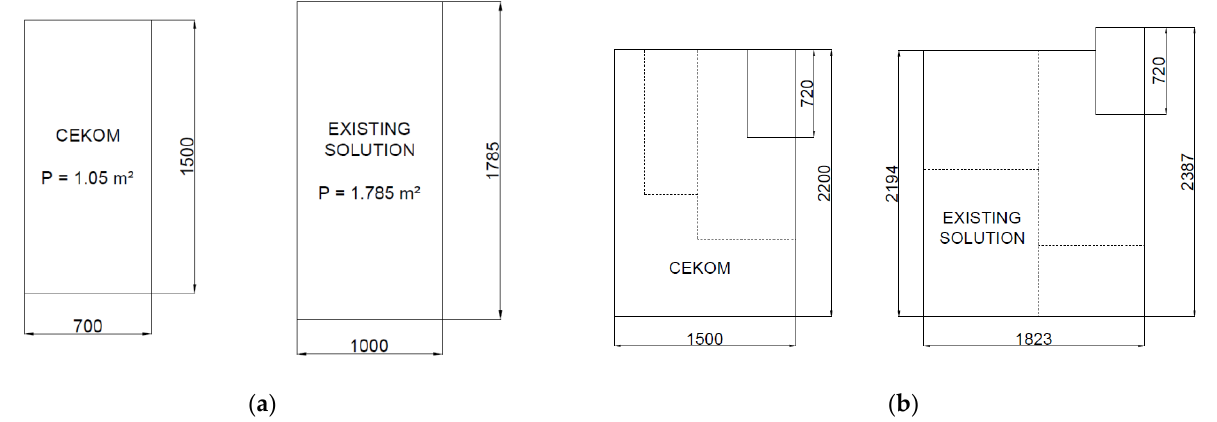
Figure 16. Proposed and existing design comparison: ( a ) footprint ( b ) sideview.